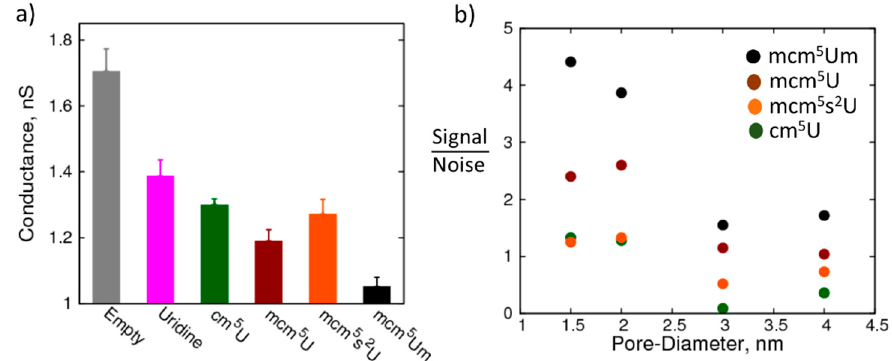
Figure 5. Detection of modified nucleosides using the nanopore: ( a ) Resistance of a 1.5 nm pore with canonical uridine and modified uridine immobilized at the center of the pore: empty pore—grey, uridine—magenta, 5-carbonyl-methyluridine (cm 5 U)—dark green, 5-methoxycarbonyl-methyluridine (mcm 5 U)—maroon, 5-methylcarboxymethyl-2-thiouridine (mcm 5 s 2 U)—orange, and 5-methoxycarbonyl-2 (cid:48) - O -methyluridine (mcm 5 Um)—black; ( b ) Degree of sensitivity (gamma, expressed as percentage difference in resistance between uridine and modified uridine, relative to uridine) decreases as pore diameter